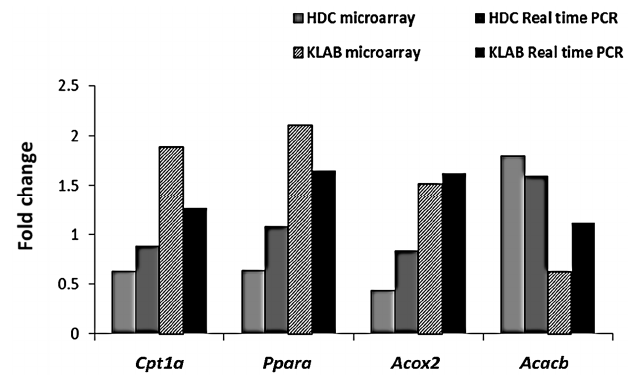
Figure 5. Comparison of real-time PCR (polymerase chain reaction) and microarray data analysis of Cpt1a , Ppara , Acox2 , and Acacb . Gene expression patterns were consistent with microarray and real-time PCR data ( Cpt1a , carnitine palmitoyltransferase 1a; Ppara , peroxisome proliferator activated receptor alpha; Acox2 , acyl-Coenzyme A oxidase 2; Acacb , acetyl-Coenzyme A carboxylase beta).